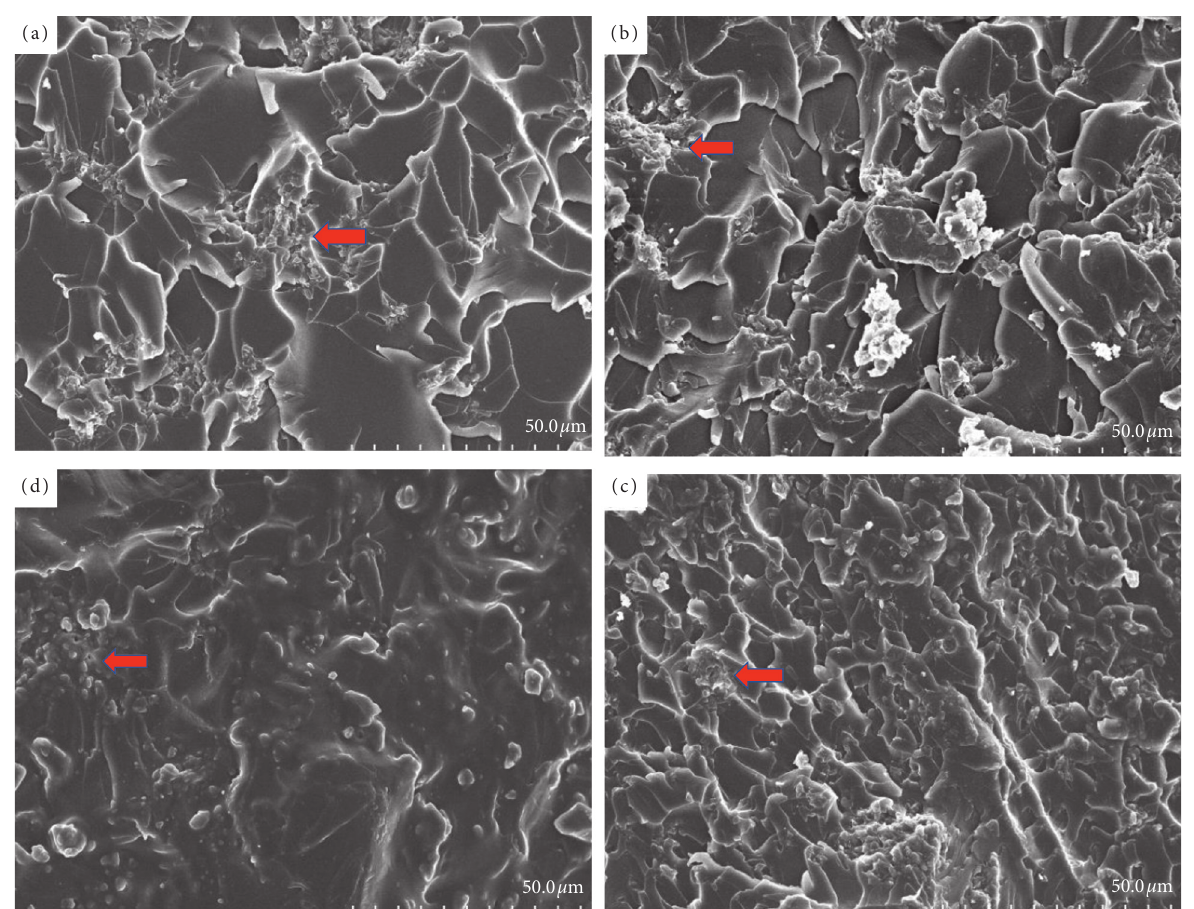
Figure 6: FE-SEM images of E 240/I.30E epoxy nanocomposite samples when stirring at different speeds: (a) 1500rpm, (b) 2000rpm, (c) 2500rpm, and (d)